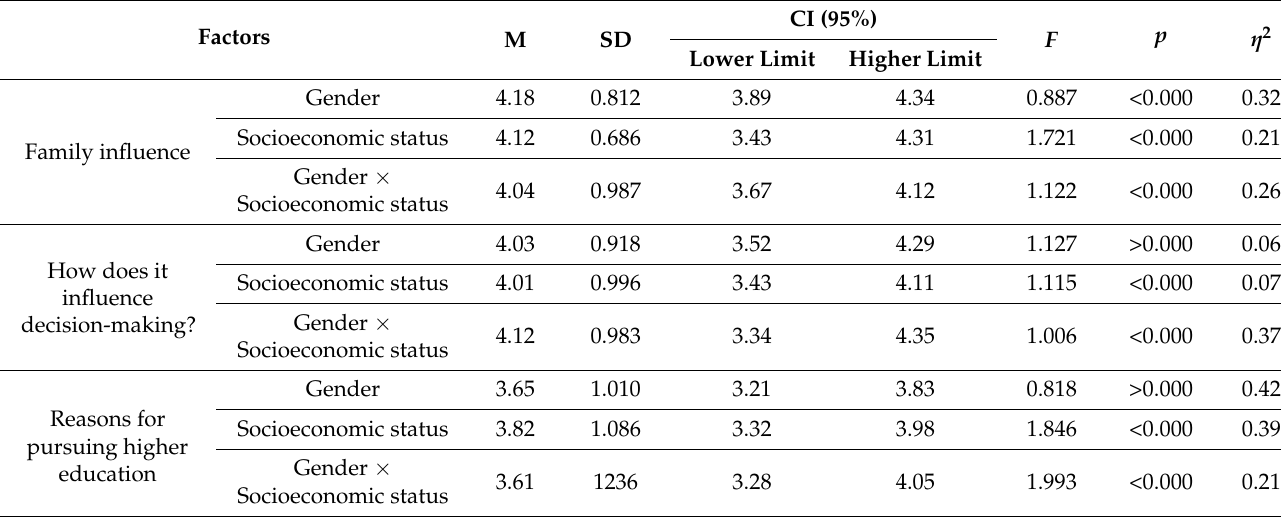
Table 3. Multivariate ANOVA (MANOVA) and effect size ( η 2 ) sums of aggregated scales for EGPUQ by gender and socioeconomic